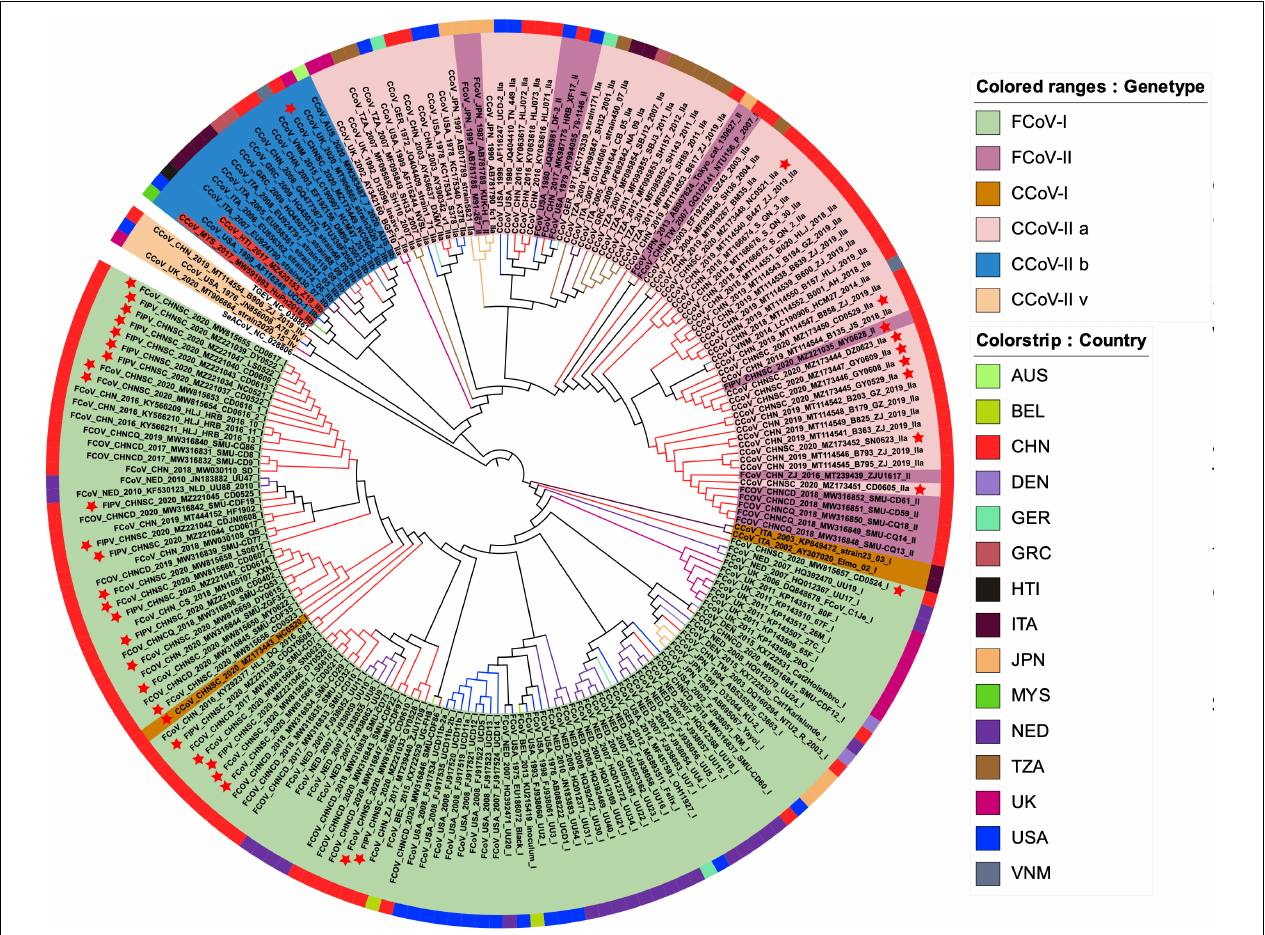
FIGURE 4 | The maximum likelihood evolutionary tree of FCoV and CCoV S1 genes. The ML tree was reconstructed by IQTREE (version 2.1.3) in PhyloSuite (version 1.2.2) with GTR + F + R10 substitution model and 10,000 ultrafast bootstrap replicates. Genotypes are distinguished by color range. The color strip and clade color represent the geographic origin of the strain. The red star represents our sample. The name highlighted in red is human-derived CCoV. Each strain is named in the form of species–region–time–accession ID–strain–genotype.